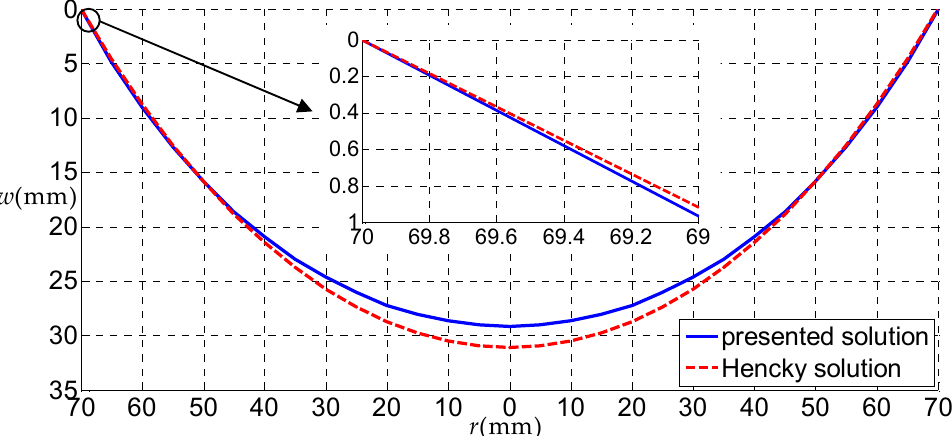
Figure 9. The variations of w with r when q = 0.2 MPa.